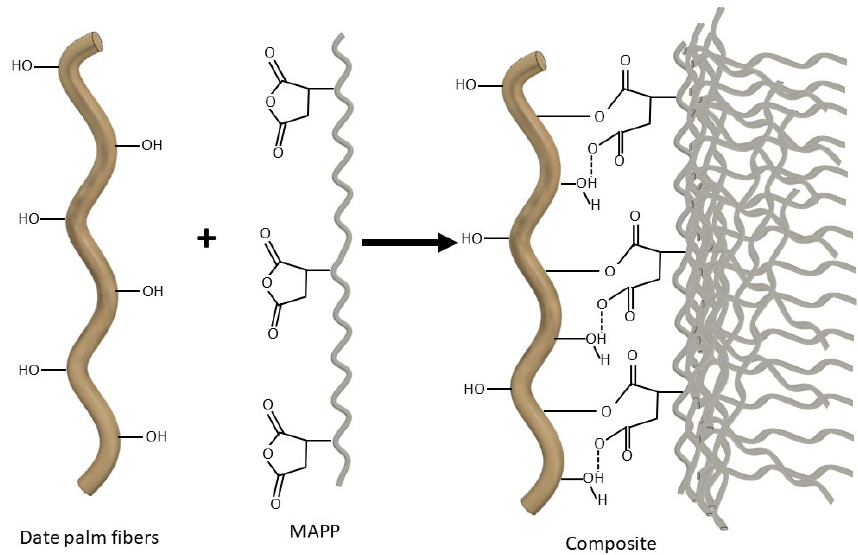
Figure 8. Scheme of date palm fibers interaction with MAPP.